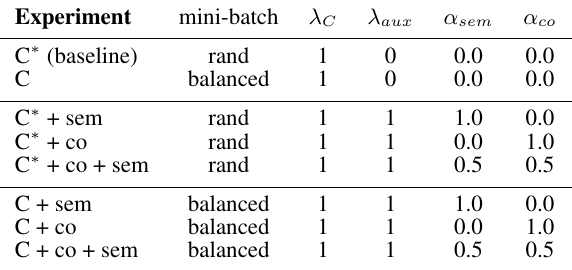
Table 3. Overview of the experiments conducted for every classification task. Experiment : name of the respective experiment. sampling : indicates the applied mini-batch sampling strategy described in section 3.3. λ C , λ aux and α sem Table 2. Statistics describing the imbalance of the class distributions in Table 1.